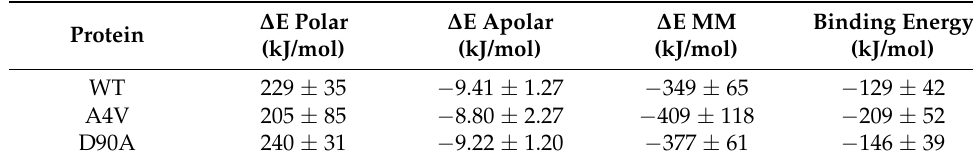
Table 4. MMPBSA analysis for the SOD1-SBL-1